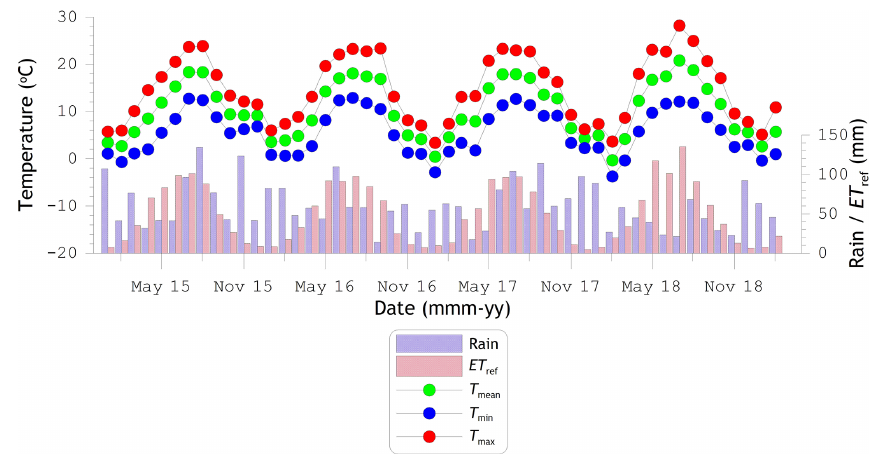
Figure 1. Monthly averages of daily mean ( T mean ), minimum ( T min ), and maximum ( T max ) air temperature and monthly sums of rainfall and reference evapotranspiration ( ET ref ), all derived from measurements collected at the three KNMI weather stations Heino, Hupsel, and